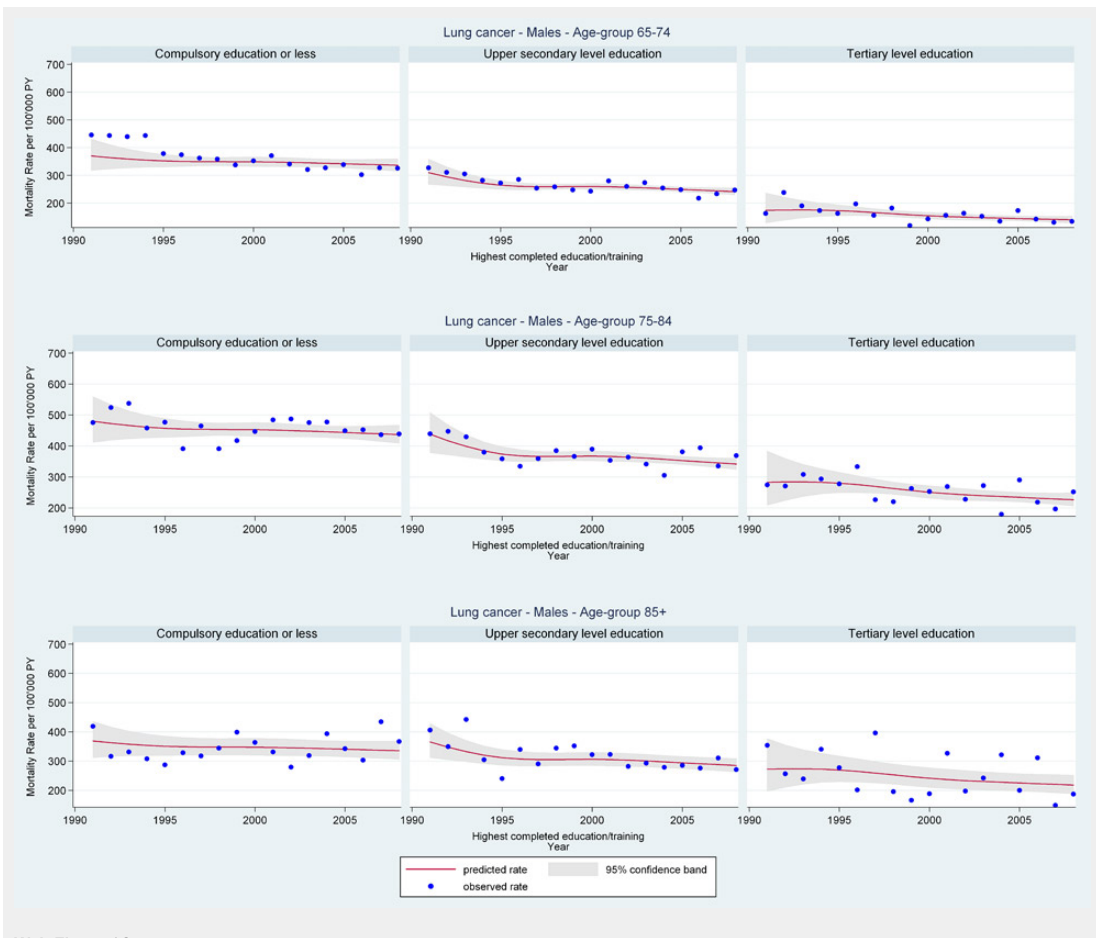
Web Figure 1C Age-specific lung cancer mortality rates from 1991 through 2008 for older Swiss men (≥65 years old) by education